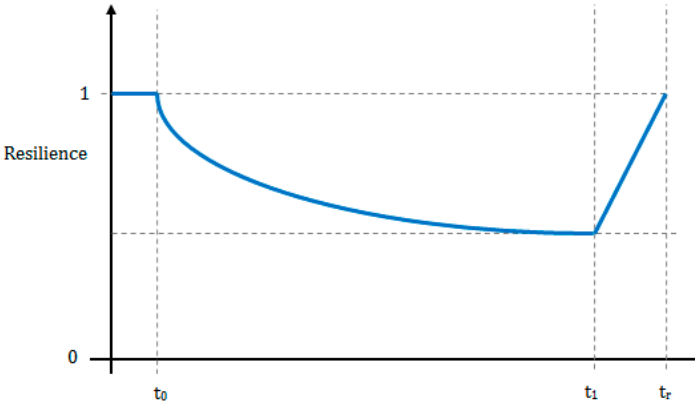
Figure 6. Resilience curve corresponding to a dynamic system performance curve.